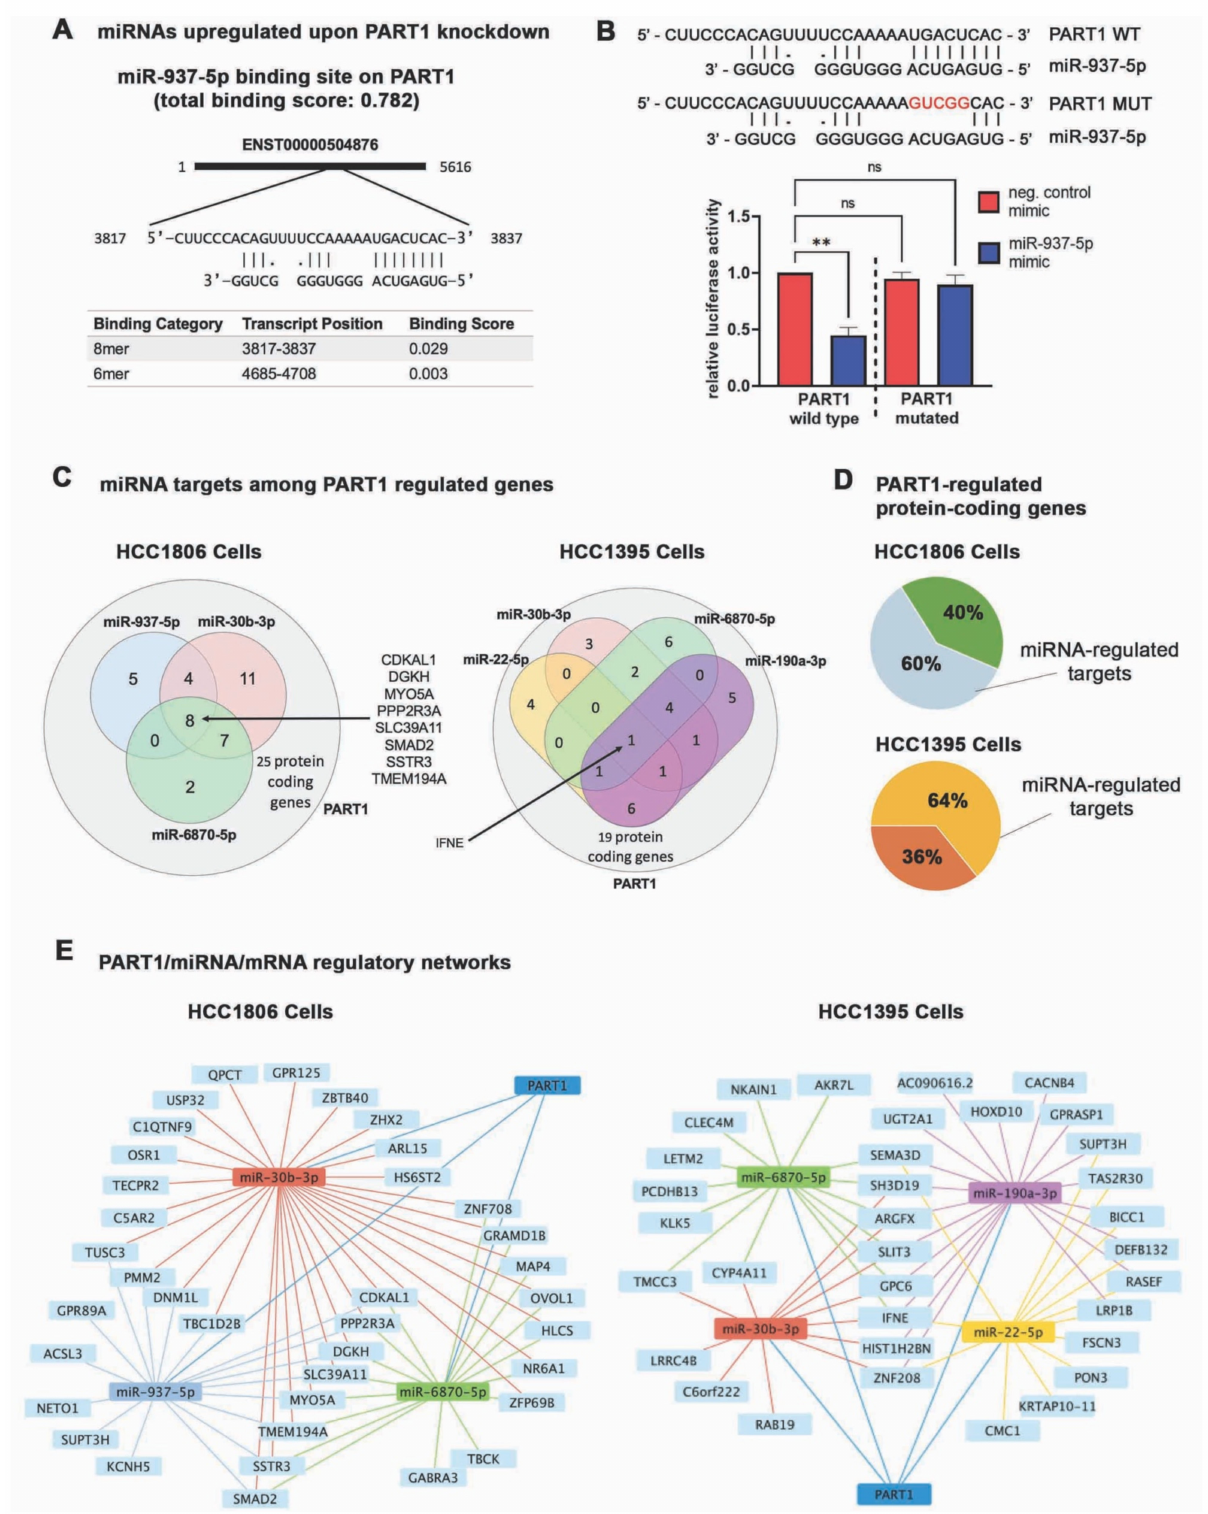
Figure 6. The PART1 -miRNA-mRNA network in TNBC cells. ( A ) The LncBase v2 predicted PART1 binding sites and affinity threshold score of miR-937-5p. ( B ) Relative luciferase activity generated by HCC1806 cells transfected with pmirGLO dual-luciferase miRNA target expression vector bearing the predicted PART1 target sequence for miR-937-5p (wildtype, WT) or a mutated version (MUT), and also treated with mimic-hsa-miR-937-5p or mimic negative control ( n = 3, significance determined by one-way ANOVA, followed by Dunnett’s post-test for multiple comparisons). Luciferase activity is